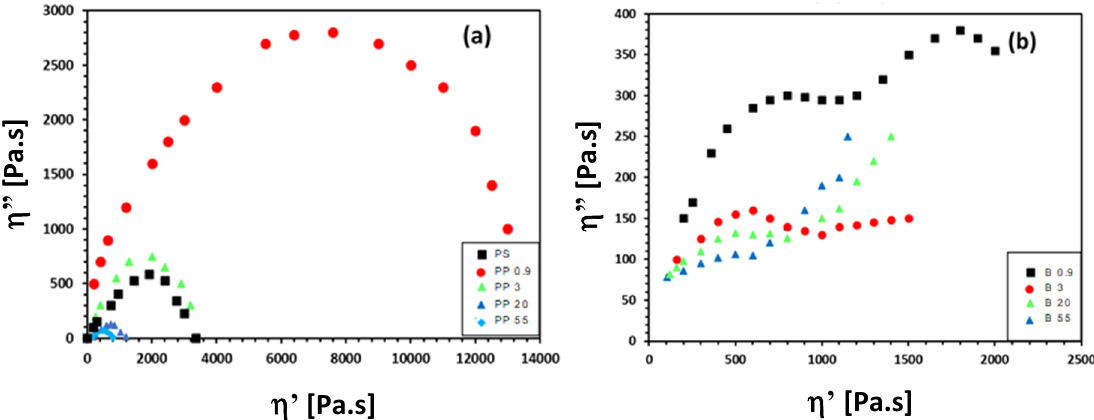
Figure 7. Cole–Cole plots illustrating relaxation behavior for ( a ) native PP and PS grades, ( b ) PS80/PP20 blends with different viscosity ratio ( K ).